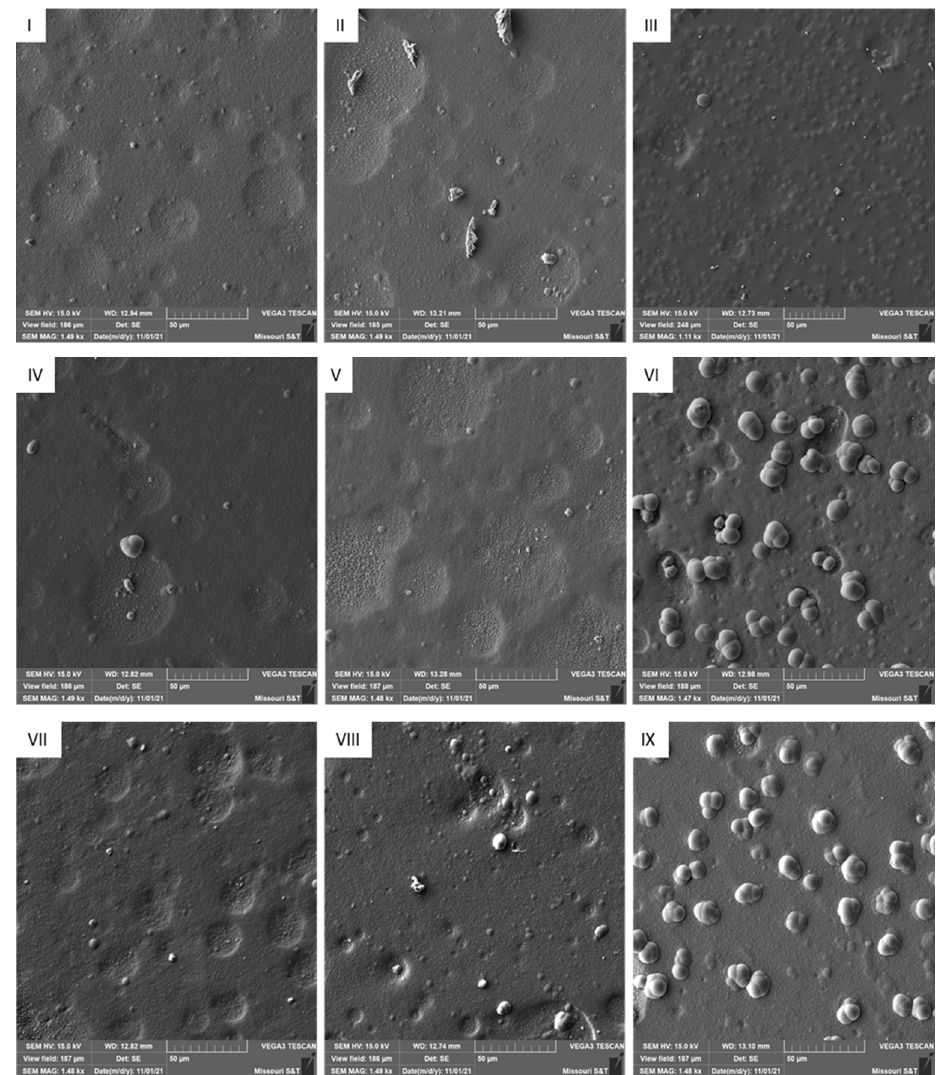
Figure 4. SEM images of Hull cell deposits at a current density of 305 A m − 2 . Labels correspond to baths I to IX in Table 1. SE mode was used due to the topographical nature caused by the nodules.